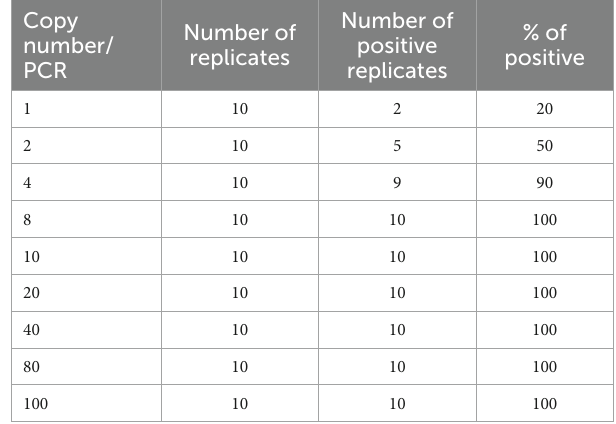
TABLE 2 Estimation of LOD of the Bmer-qPCR using diluted B. miyamotoi FR64b